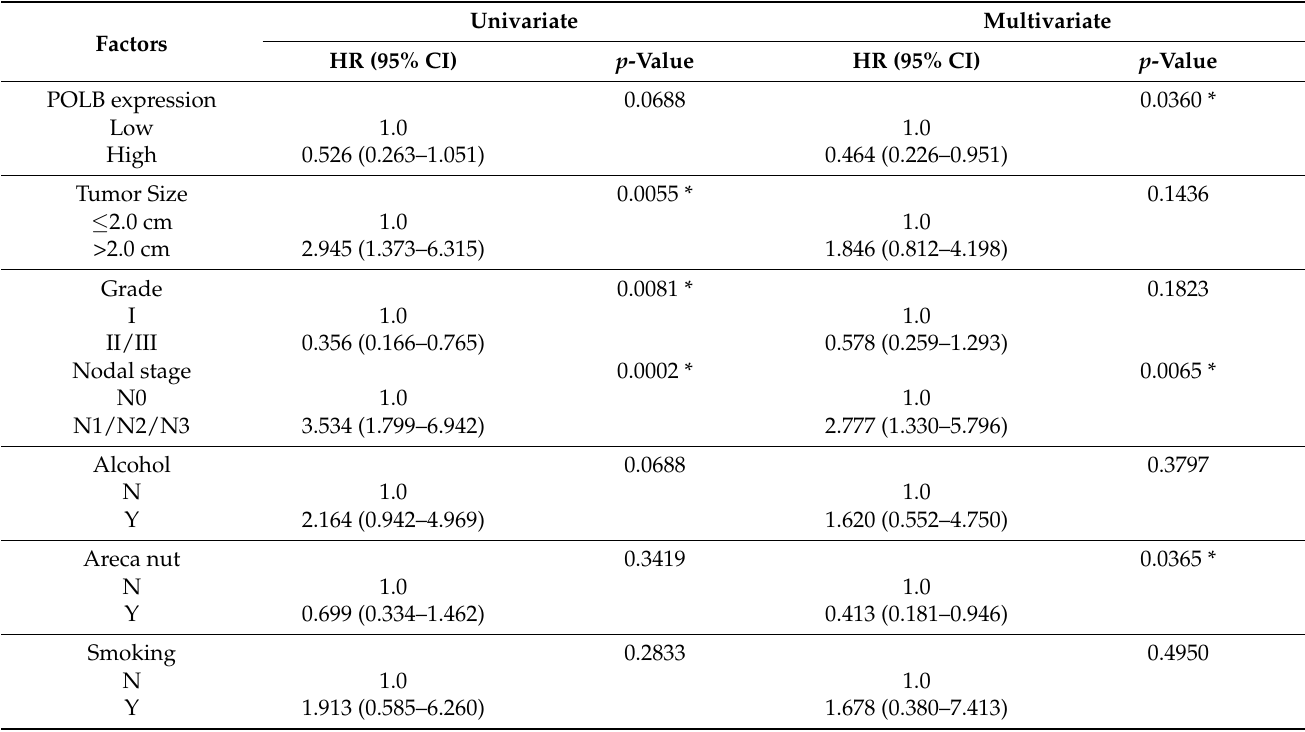
Table 3. Univariate and multivariate logistic analysis of clinicopathological independent prognostic factors for survival of oral cancer patients ( n = 133). Statistical analysis was performed using Cox multivariate